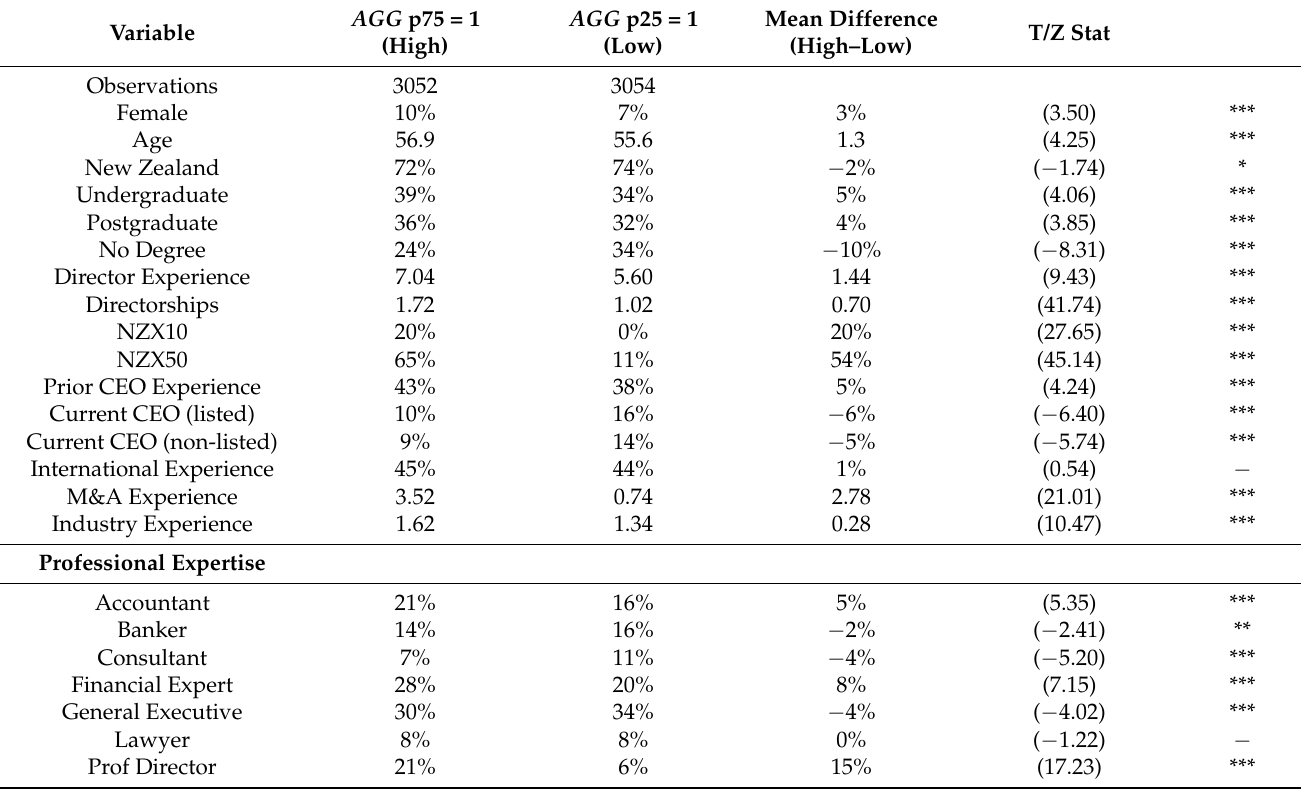
Table 3. Attributes of high-connected versus low-connected